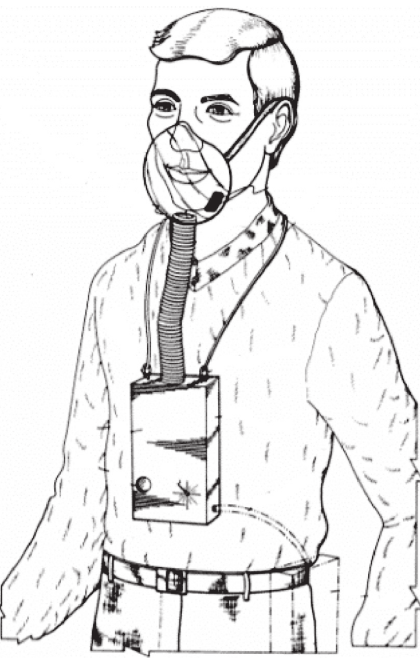
Figure 1: UV-C air sterilization device concept